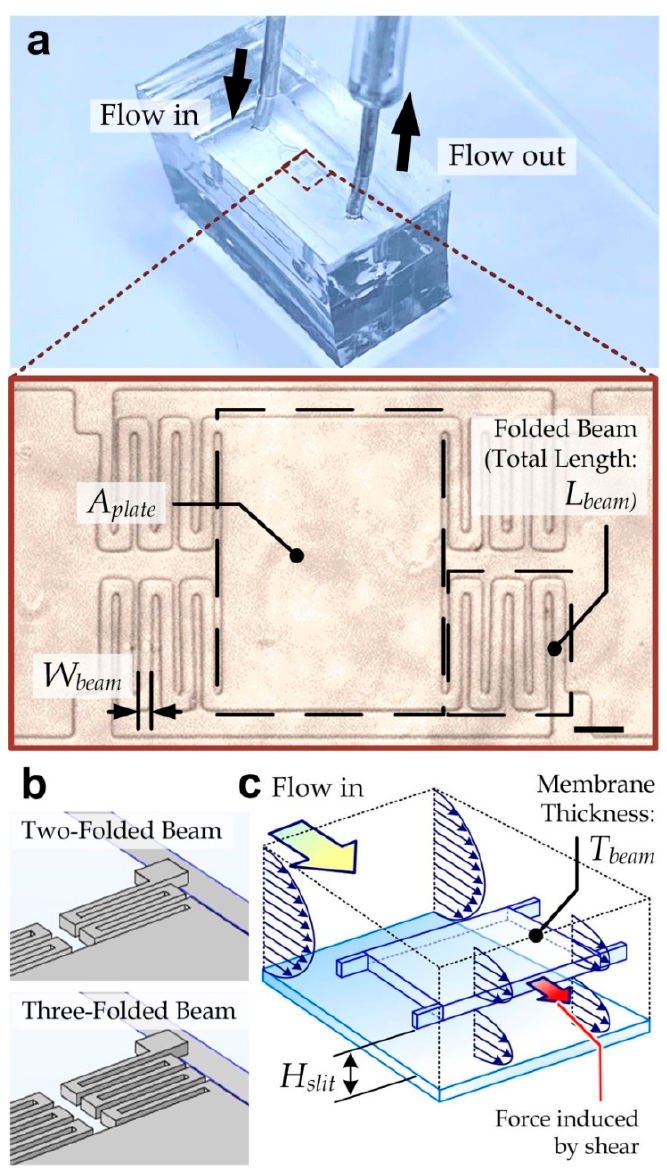
Figure 1. ( a ) Micro-viscometer containing a suspending micromembrane located along a microchannel. Inset: Enlarged microscopic image of the suspending membrane. Scale bar: 50 µ m. ( b ) Designs of the two-folded beam (length: 800 µ m) and three-folded beam (length: 1200 µ m). ( c ) Key external forces acting on the suspending membrane. While the test sample is flowing along the channel, the shear stress over the membrane leads to the beam deflection and membrane displacement.